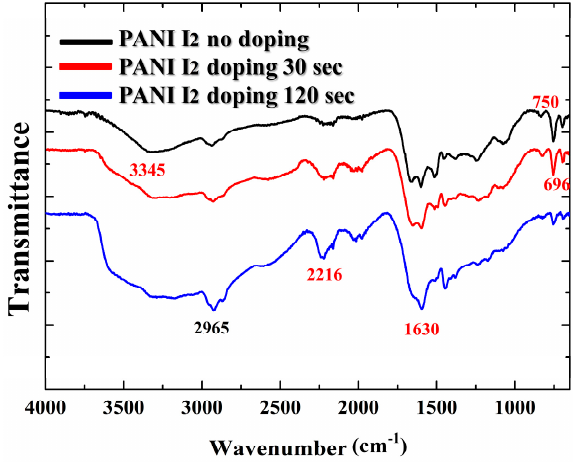
Figure 5. Fourier transform infrared spectroscopy (FT-IR) spectra of PANI films grown on glass 226